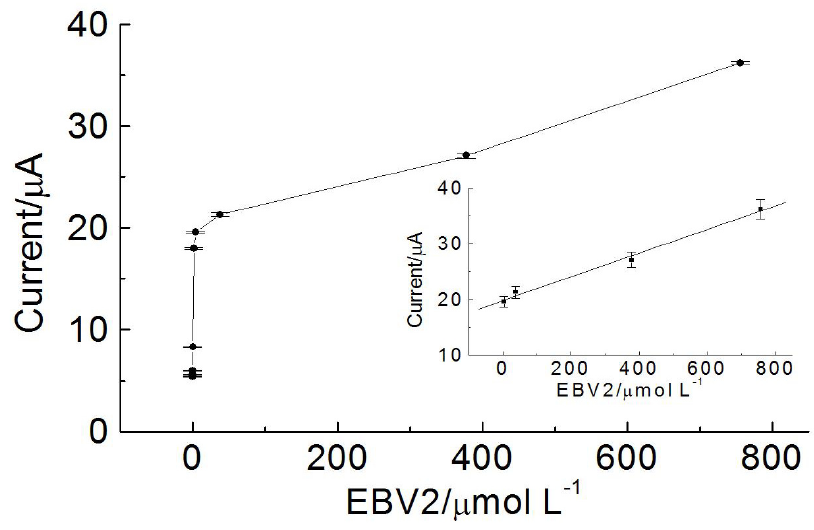
Figure 6. Electrochemical response for the oxidation signal of ethidium bromide (1 × 10 − 6 mol·L − 1 ) obtained after the hybridization of modified electrode containing the probe EBV1 (126 µmol·L − 1 ) with different concentrations of EBV2 (0, 0.0010, 0.010, 0.10, 1.89, 3.78, 37.8, 378 and 756 µmol·L − 1 ). Inset shows linear range of current peak vs. concentration of EBV2.